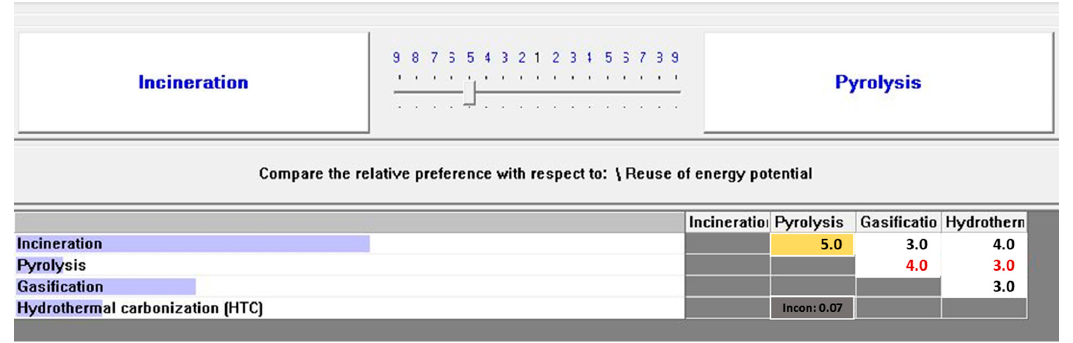
Figure 3. Example of pairwise comparison of the alternatives by a single criterion in Expert Choice (incineration vs. pyrolysis).